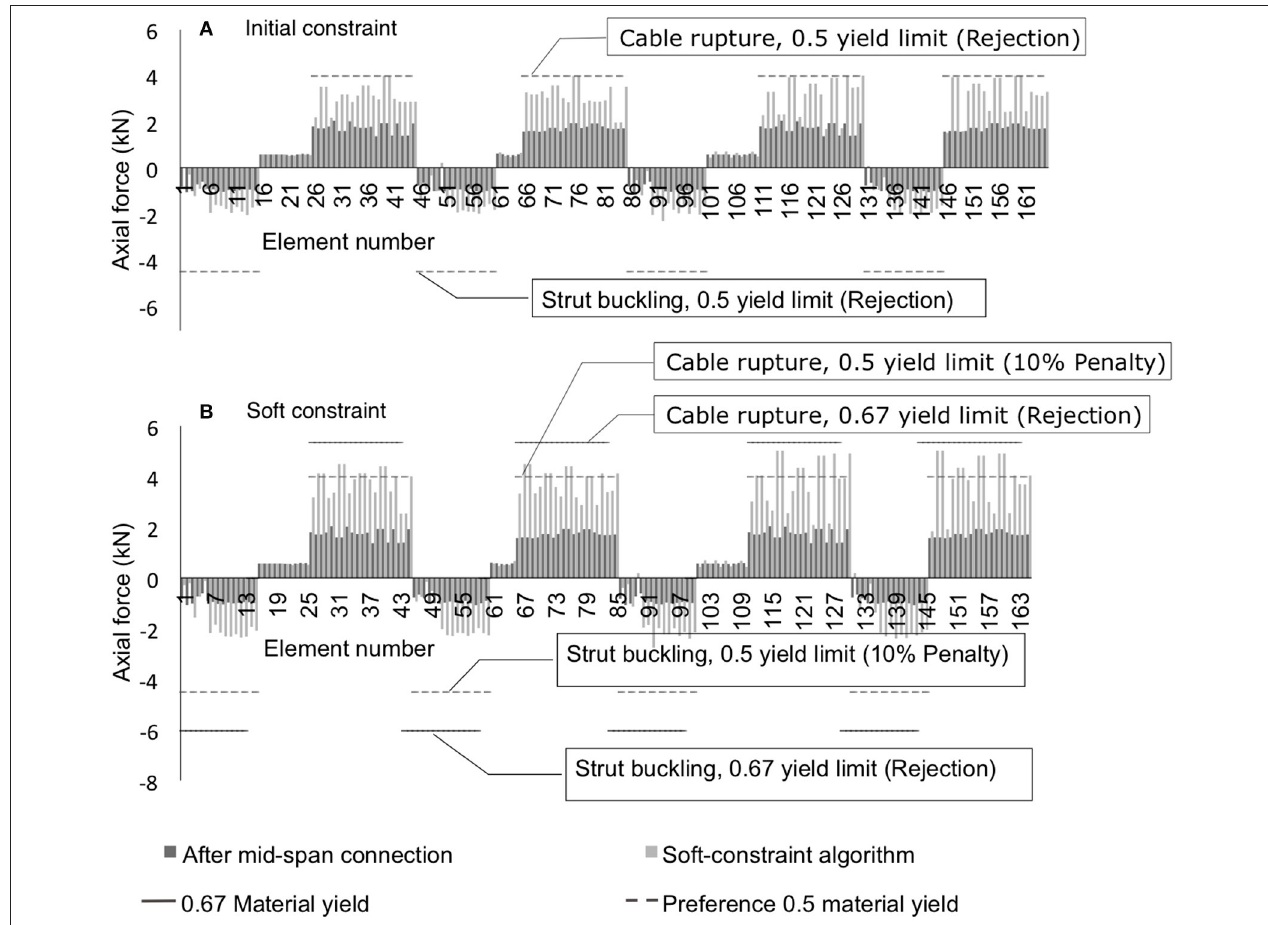
FIGURE 12 | Comparison of simulated element internal forces using an initial self-stress algorithm (A) , and soft-constraint self stress algorithm (B) . The dark gray bars show the original element forces and the light gray bars show the element forces with application of each constraint